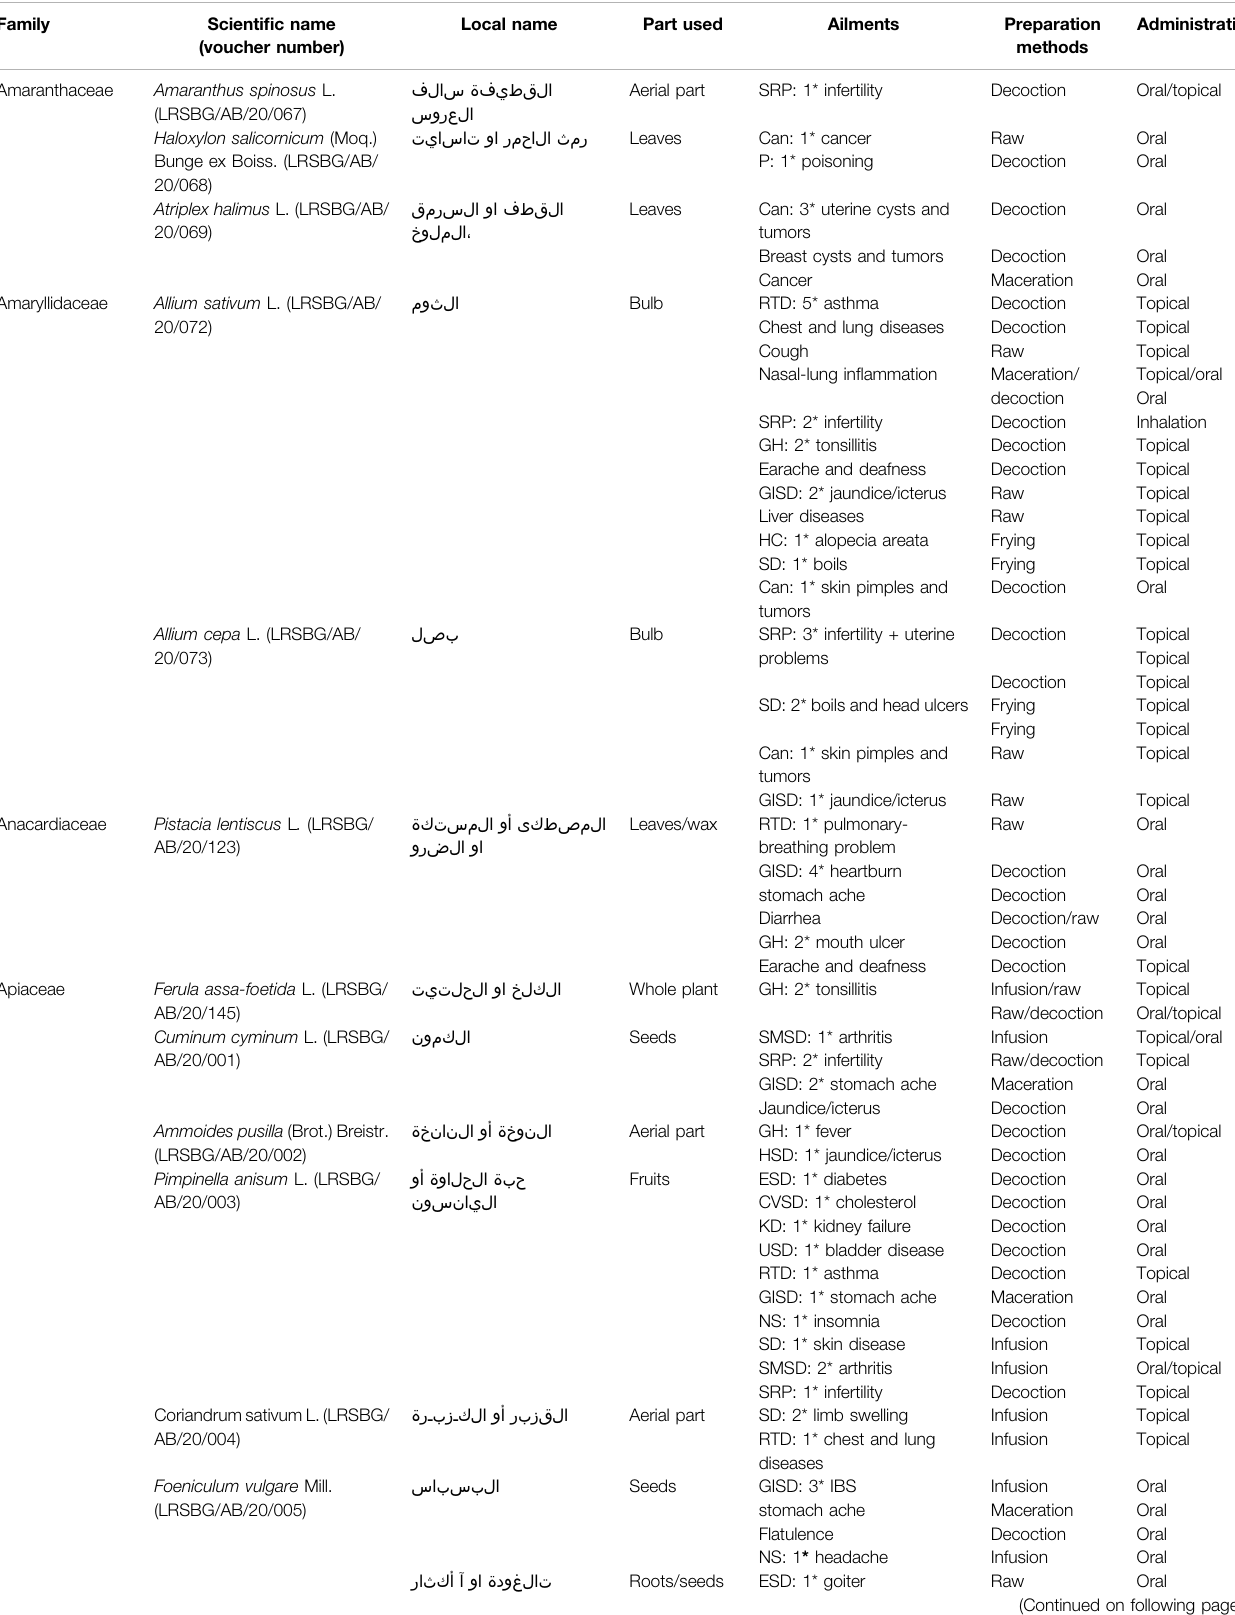
TABLE 7 | List of medicinal plants used by traditional healers in the study areas.